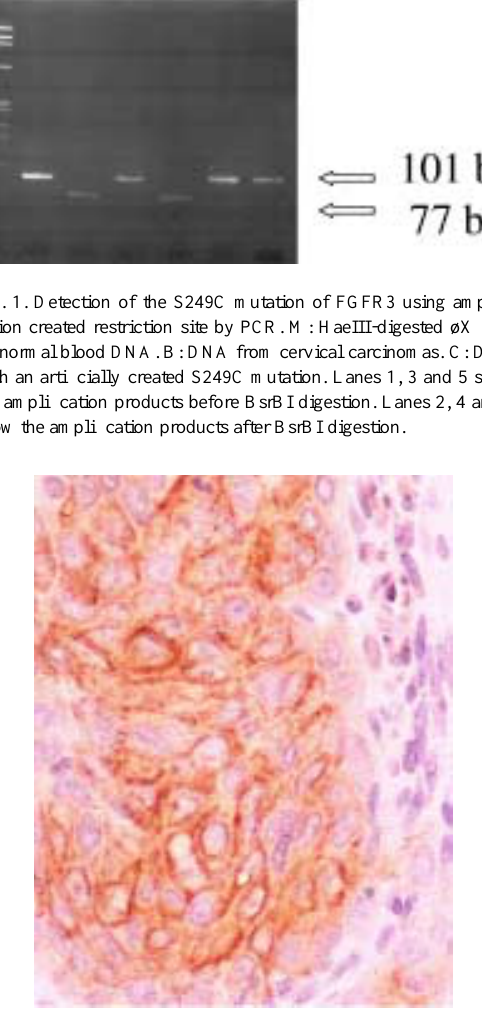
Fig. 2. Expression of FGFR3 protein in cervical carcinoma showing membrane and cytoplasmic staining in most tumor